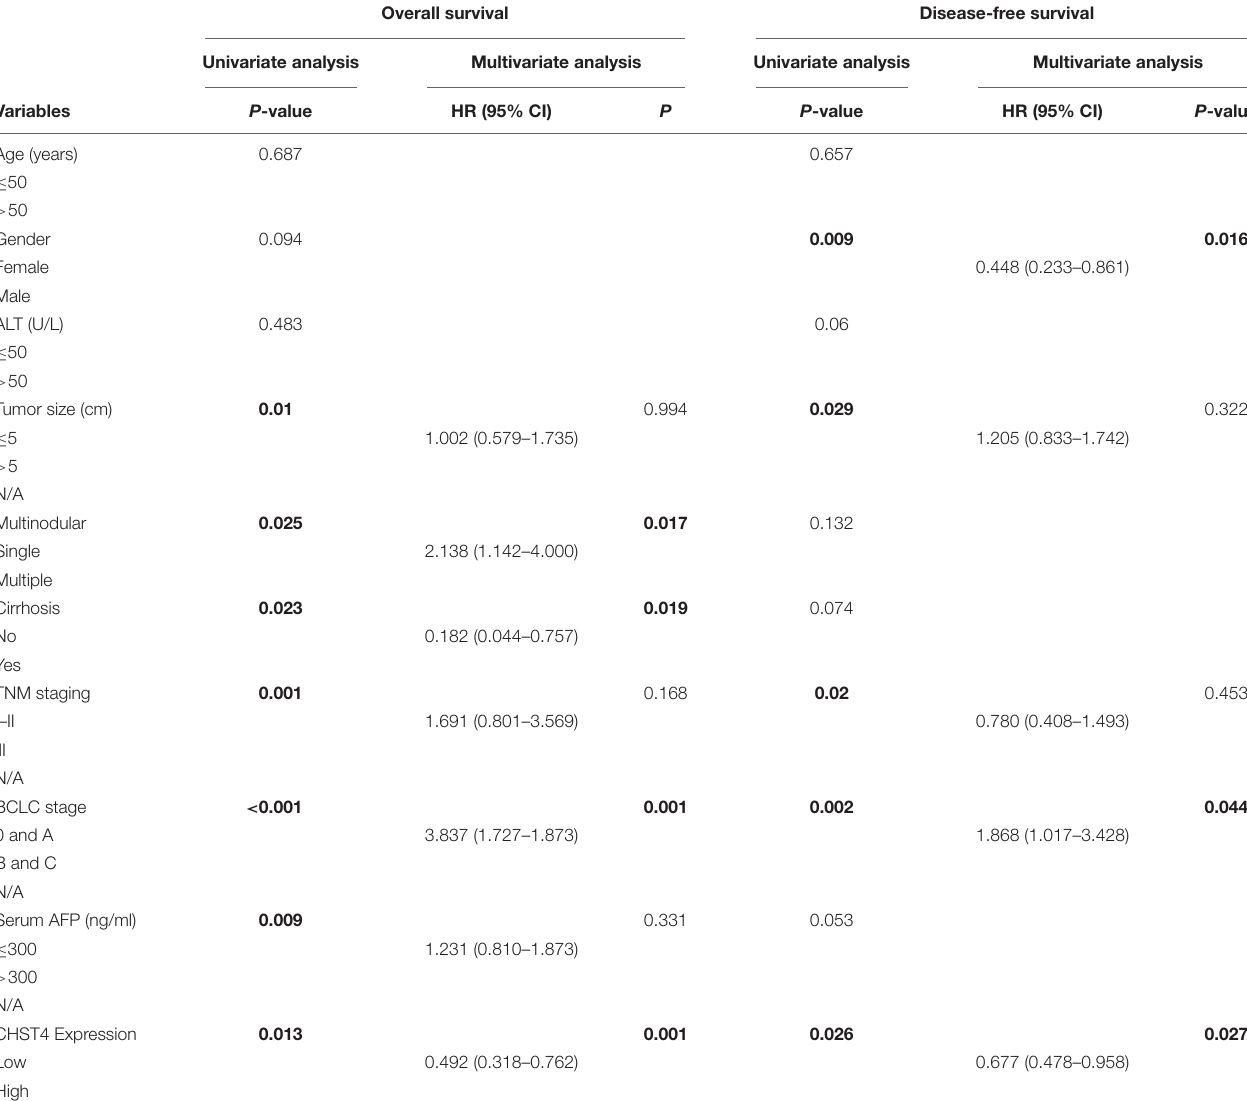
TABLE 2 | Univariate and multivariate analyses of prognostic factors of HBV-HCC patients from the GSE14520